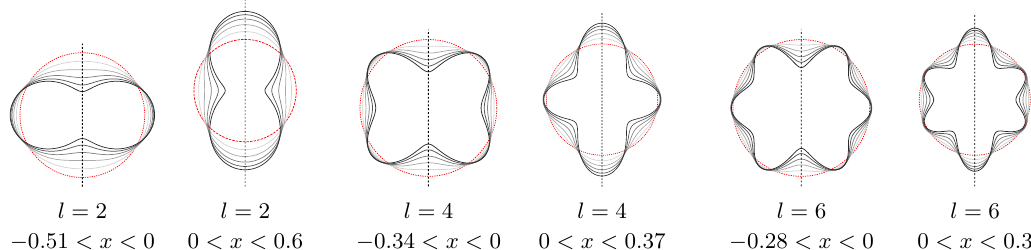
Figure 1 . Embeddings of the geometries (2.5) in R 3 for l = 2 , 4, and 6; the full geometries are surfaces of revolution obtained by rotating about the dotted vertical line. The red dotted circle represents the undeformed round sphere, while from light gray to black the other curves show even spacings in x for the labeled range with x related to (cid:15) as in (2.9). The black curves, corresponding to the extremal values of x for each l , show the largest values of x for which we will present results in section